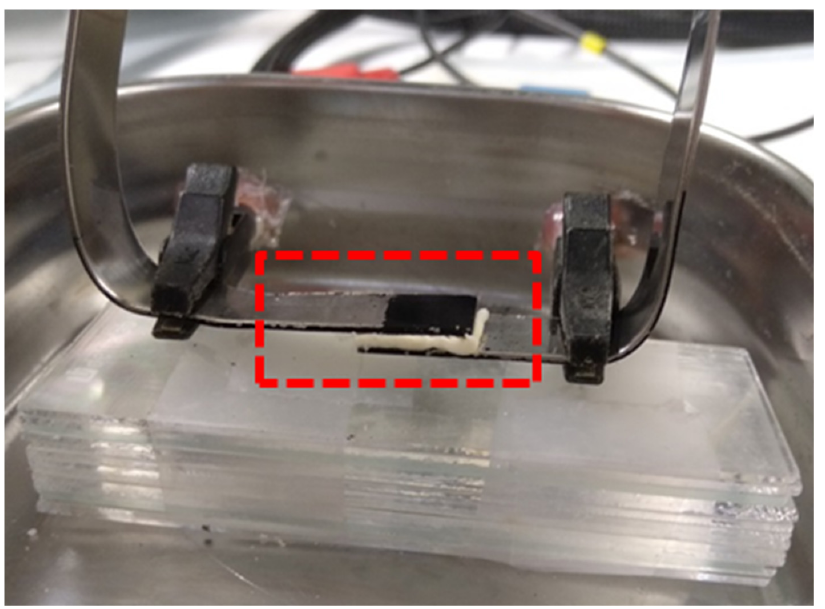
Figure 2. Sandwiched configuration used to perform EIS measurements on κ C, CMC, PGGA and PEA hydrogels. The hydrogel separating the two PEDOT electrodes are marked by the read box.